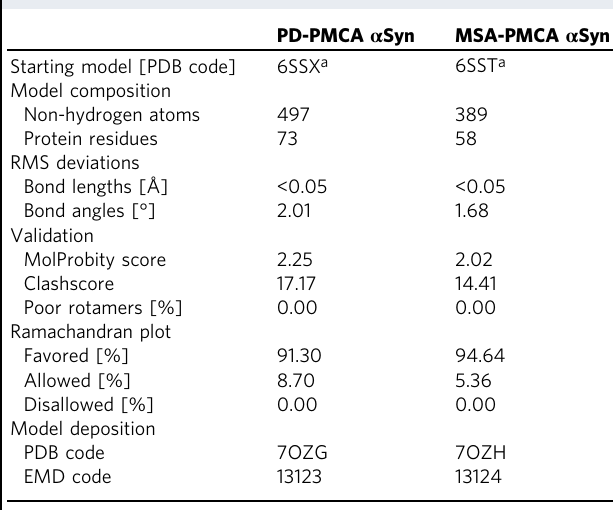
Table 1 Cryo-EM structure determination statistics. Table 2 Model building